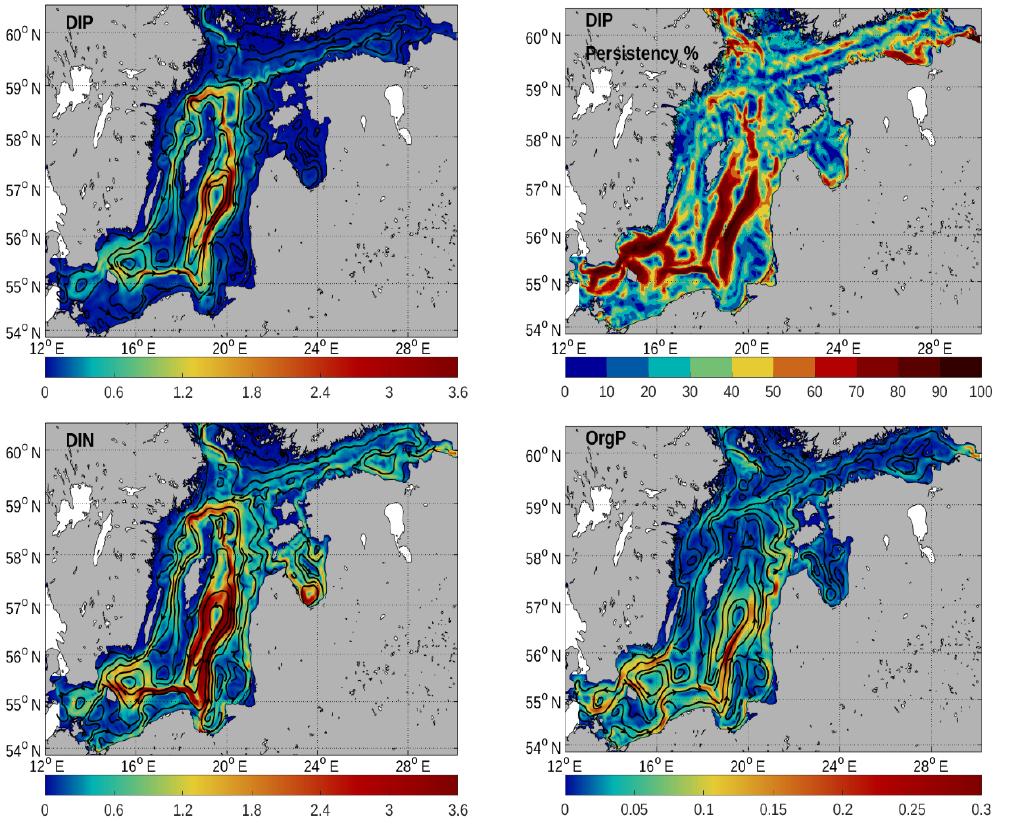
Figure 7. Annual mean DIP transports and the corresponding DIP persistency, DIN and OrgP transports for REANA averaged for the period 1970–1999. The black solid lines with arrows show the streamlines and direction of transports. The magnitude of transports (ktkm − 1 yr − 1 ) and the persistency (%) are shown by the background color. The corresponding values are shown in the colored